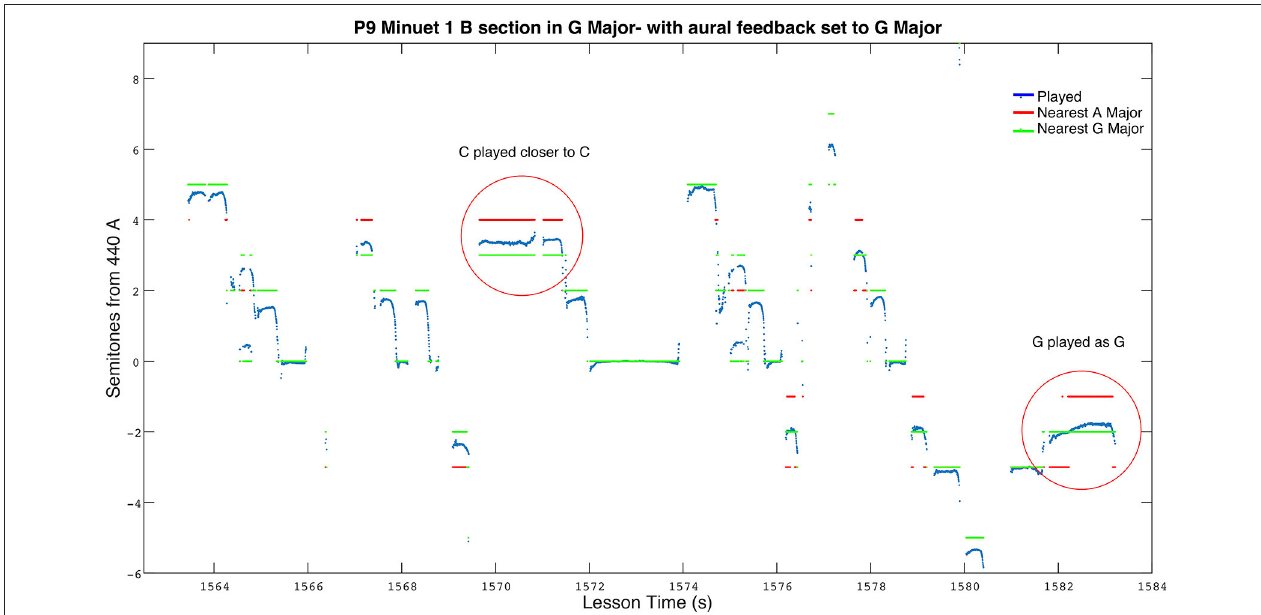
FIGURE 7 | Section of P9 playing Bach’s Minuet 1. Aural feedback is correctly set to G Major and P9 can be seen using C ♮ and G ♮ instead of C ♯ and G ♯ . Red lines represent the nearest note in A Major, with green lines the nearest note in G